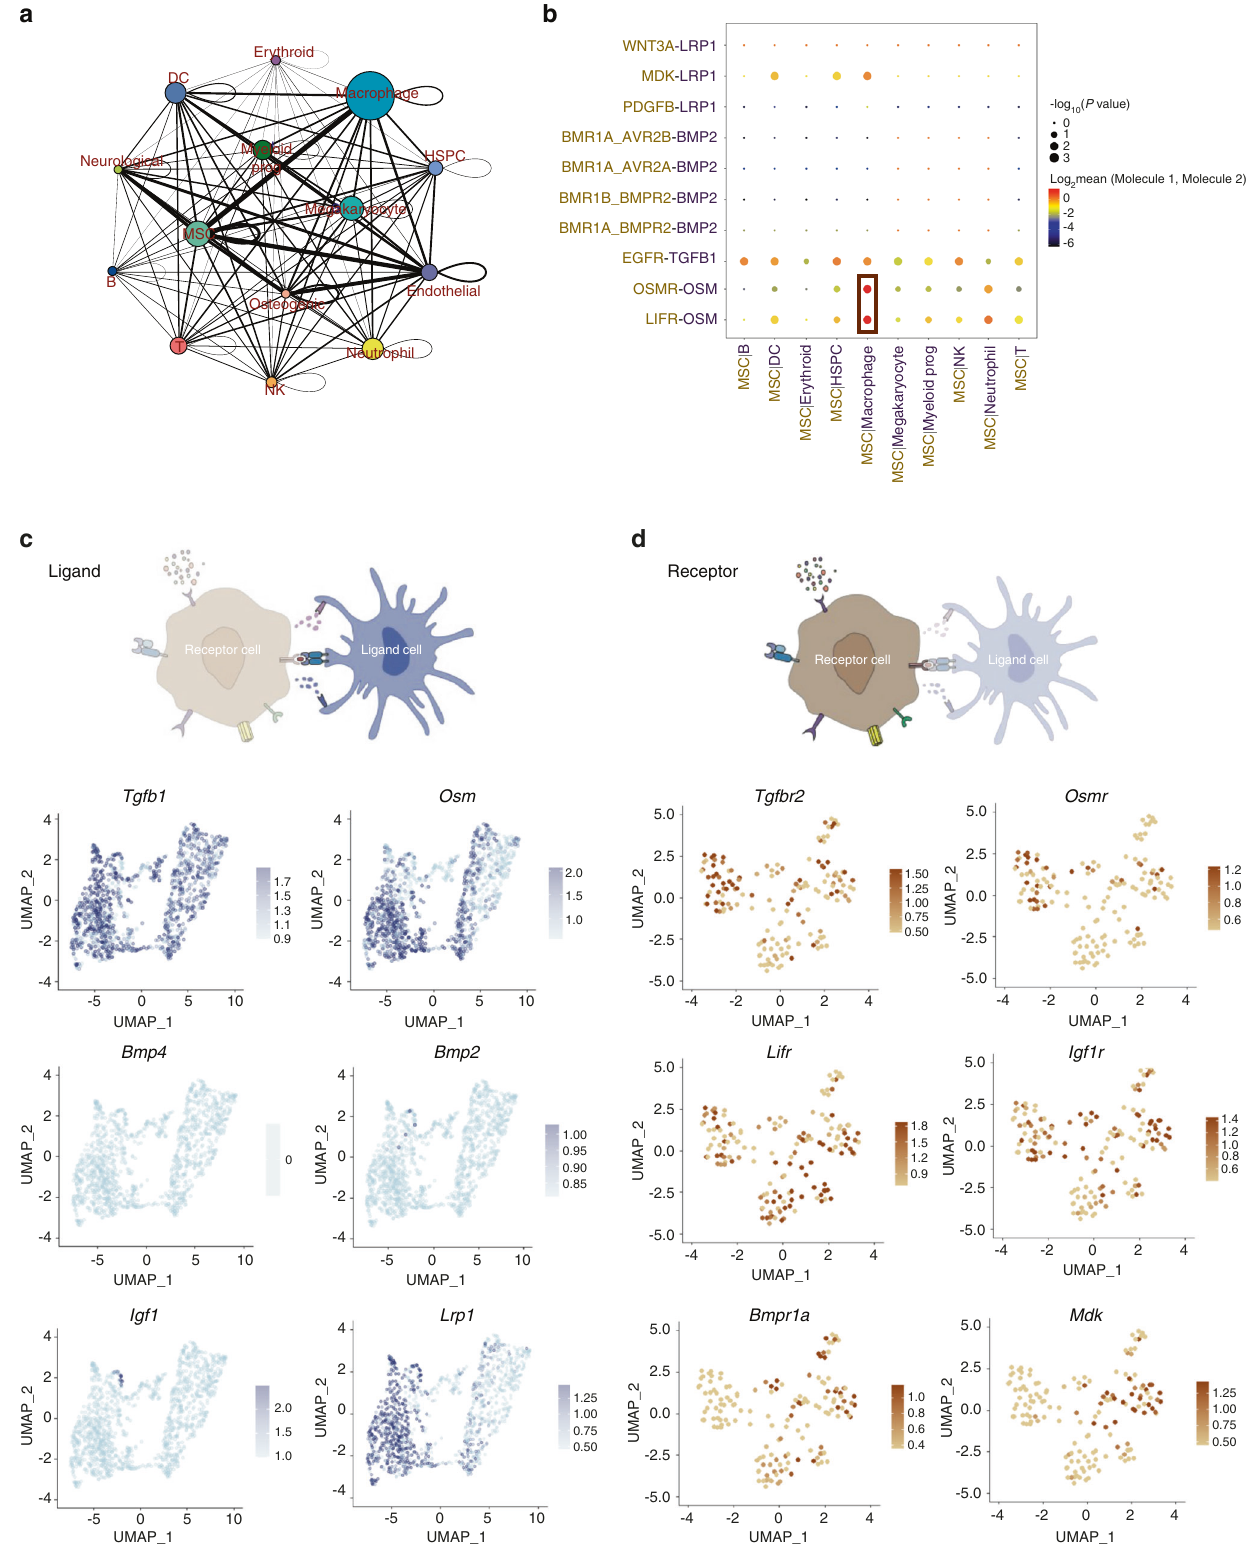
Fig. 2 Cell – cell interaction between immune cells and stromal cells in alveolar bone marrow. a Network diagram of the cell – cell interaction of different cells in the alveolar bone marrow. The size of the circle represented the number of interactions with all other types of cells, and the thickness of the line represented the interaction number of cells between the line. b Visualization of the selected macrophage-MSC crosstalk pathway. c Expression of the ligands in monocytes/macrophages. d Expression of the receptors in stromal cells (MSC, osteoblasts, endothelial cells, neurological